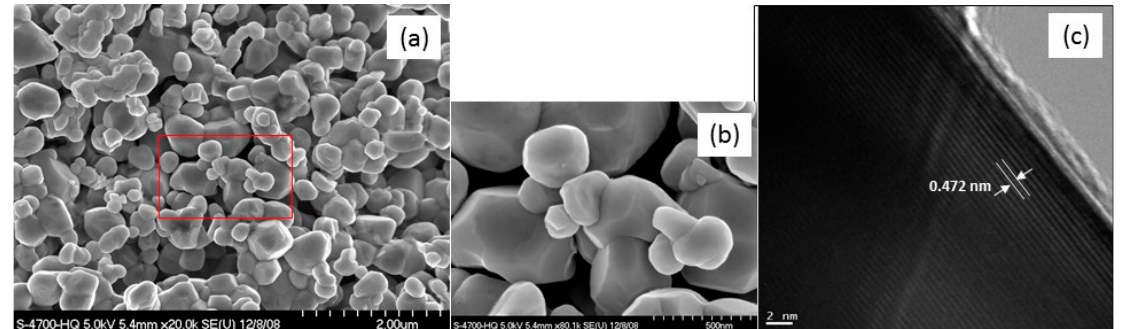
Figure 13. ( a , b ) SEM images of NMC synthesized at R = 2 via wet chemical method at different magnifications; ( c ) HRTEM image showing the fringe system corresponding to the spacing between (003) lattice planes in the mR 3 space group.